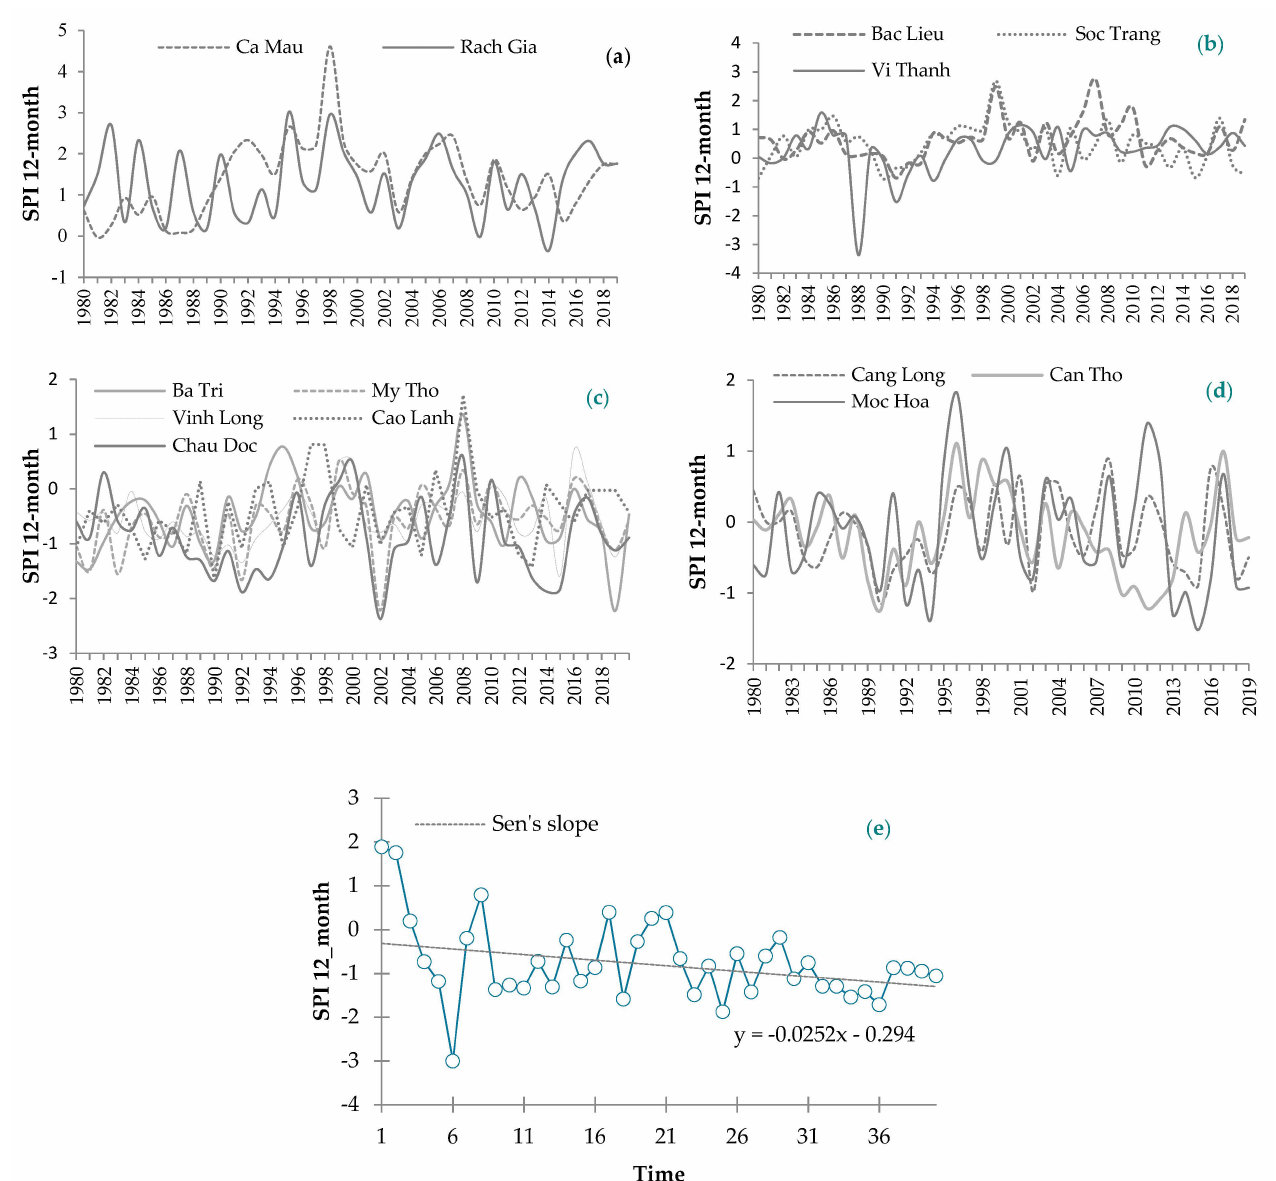
Figure 3. The SPI 12-month drought time series at 5 clusters, 1980–2019: ( a ) Cluster No.1, ( b ) Cluster No.2, ( c ) Cluster No.3, ( d ) Cluster No.4, ( e ) Cluster No.5 (only Tri Ton Station in cluster No.5 tends